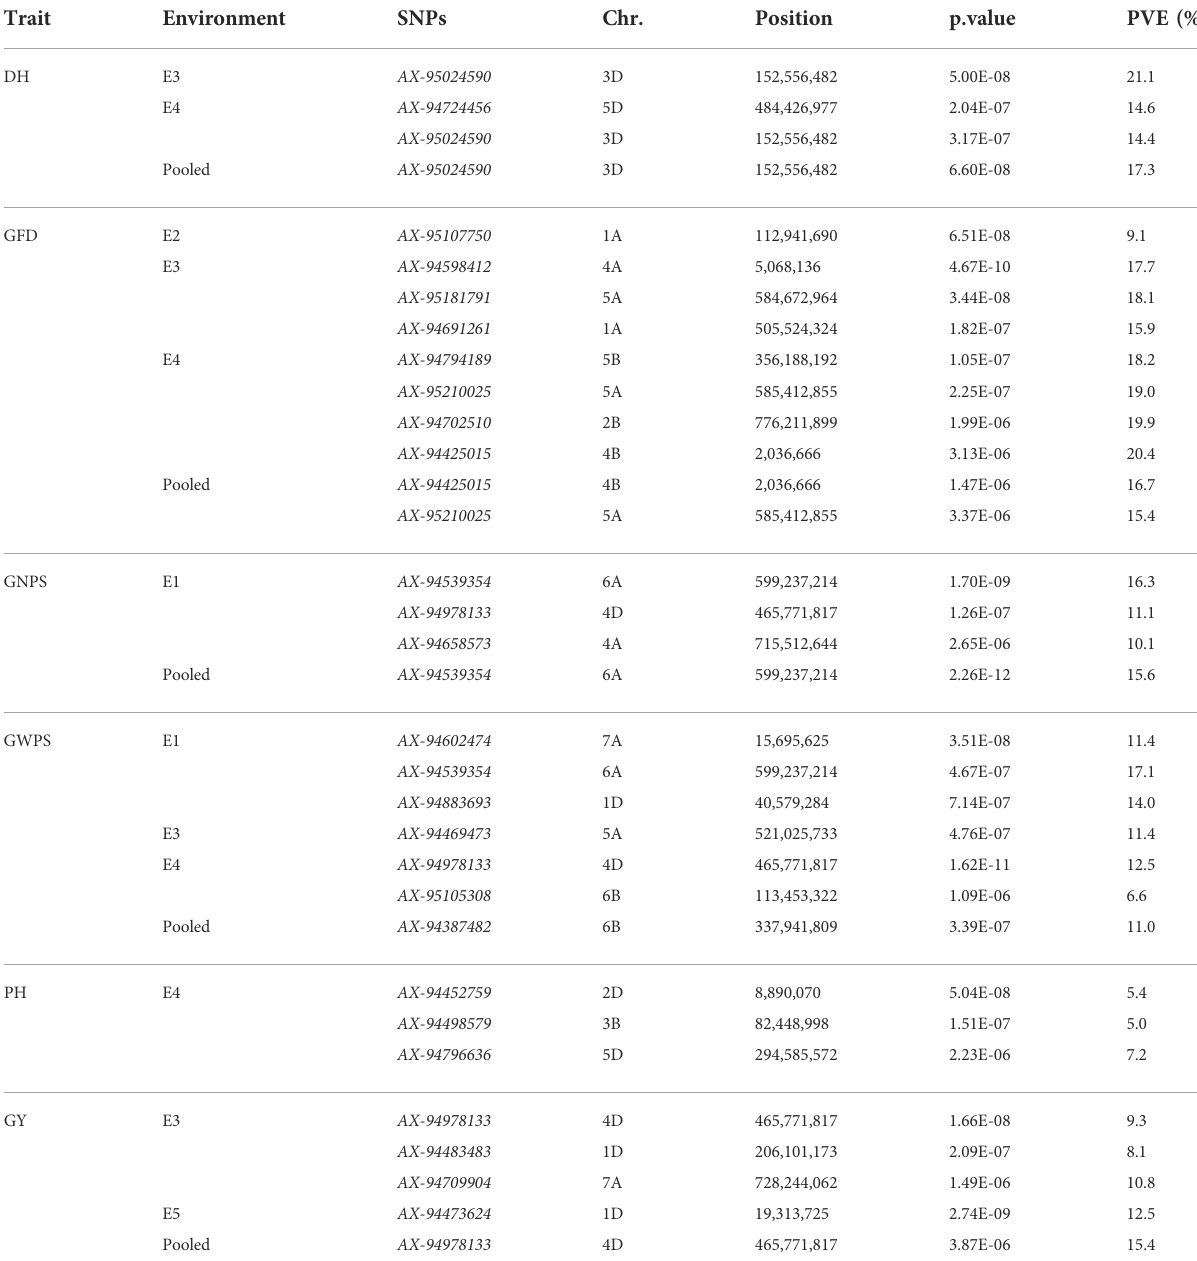
TABLE 3 Marker trait associations for grain yield and component traits in GWAS panel evaluated at Dharwad, IARI Delhi, IARI Jharkhand, Karnal, and Ludhiana during 2020 – 2021. Trait Environment SNPs Chr. Position p.value PVE